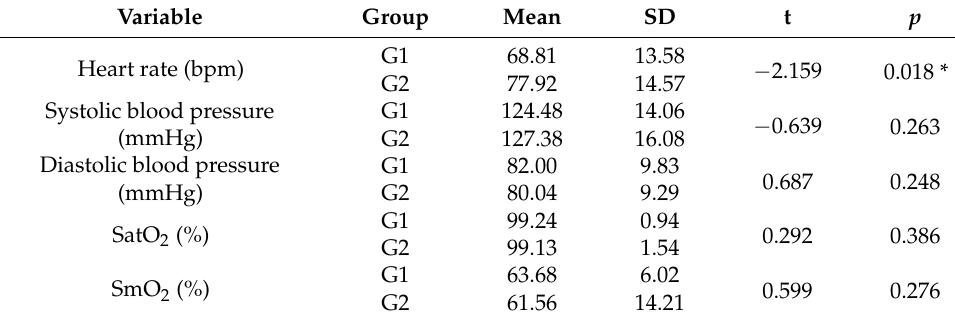
Table 2. Basal physiological